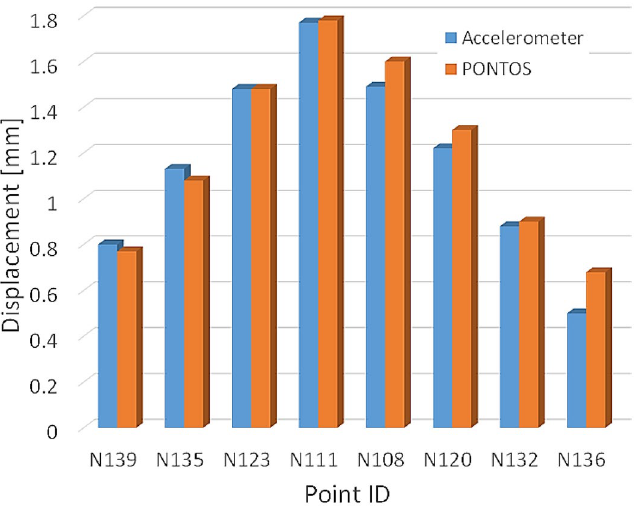
Figure 3. Displacement determined by means of accelerometer and PONTOS DIC system 30